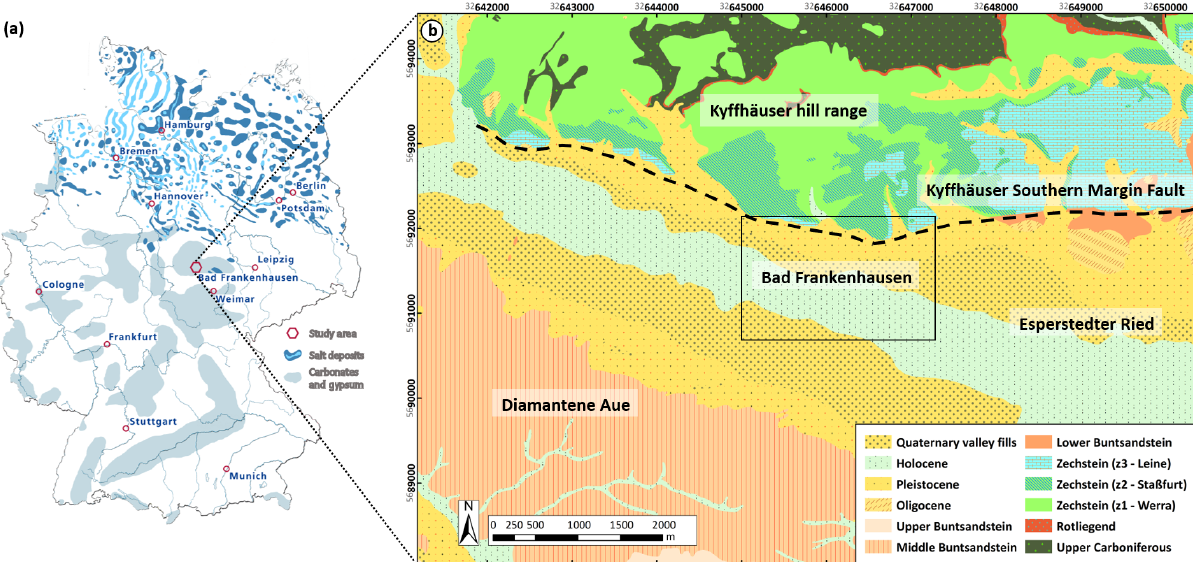
Figure 1. Geological overview of the study area. (a) Distribution of soluble deposits in Germany and location of the study area Bad Franken- hausen in the transition zone between salt and carbonate deposits, after Krawczyk et al. (2015). (b) Geological map showing Permian, Triassic, and Cenozoic deposits of the study area and its surroundings (simplified after Schriel and Bülow, 1926a, b; CS: ETRS 1989 UTM Zone